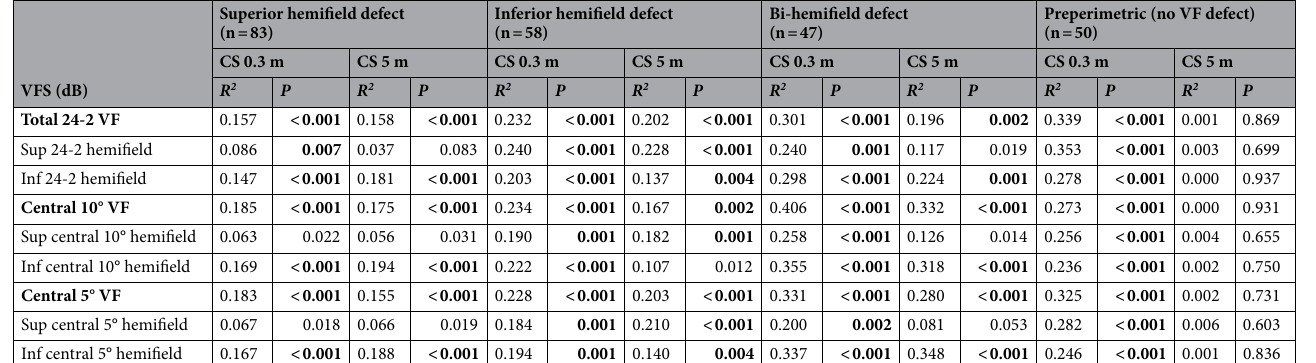
Table 5. Correlations between the contrast sensitivity and visual field sensitivities in various sectors according to the location of visual field defect in POAG eyes. Bonferroni correction was used for multiple comparisons. P value < 0.0083 (0.05/6) was considered significant. Statistically significant values are shown in bold. POAG = primary open-angle glaucoma; CS = contrast sensitivity; VFS = visual field sensitivity; VF = visual field; Sup = superior; Inf = inferior.